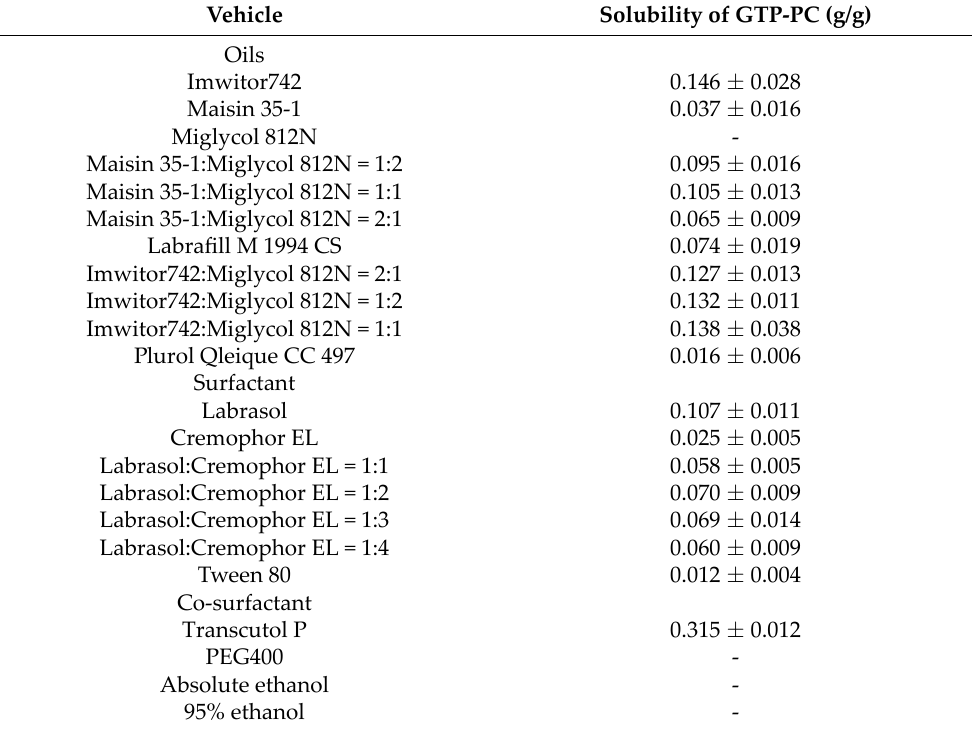
Table 5. The solubility of GTP‑PC in various vehicles at 37